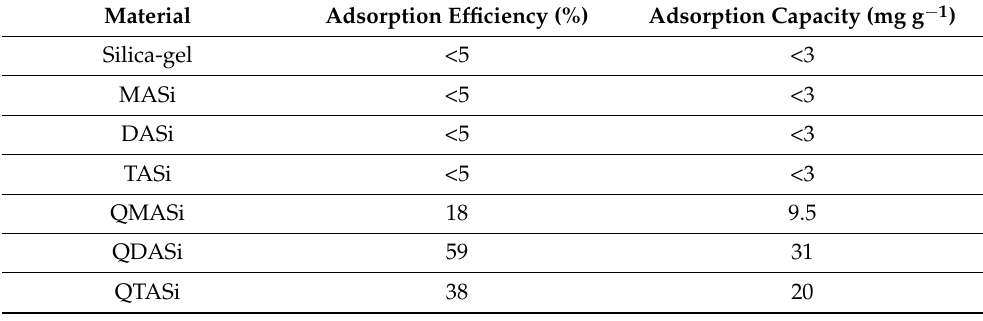
Table 1. Adsorption efficiencies and capacities of amine-functionalized silica-gel and their quaternary salts on pure HEP standard solution.